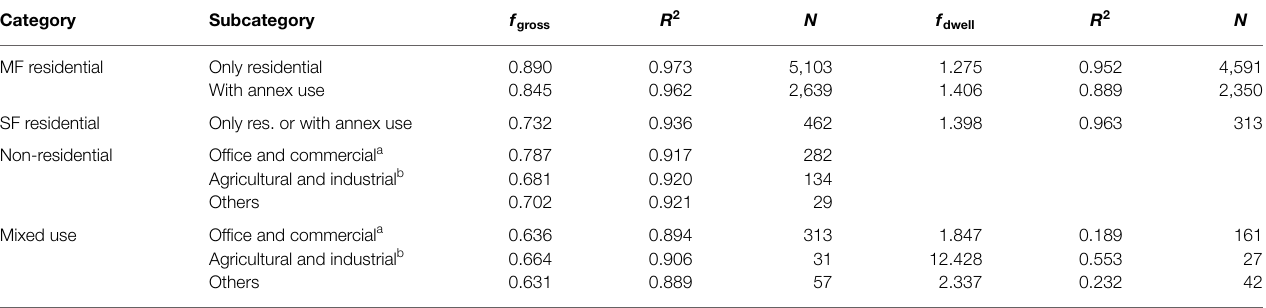
TABLE 1 | Regression coefficients between heated floor surface and gross surface ( f gross ) and between heated floor surface and dwelling surface ( f dwell ), as observed in the IDC database. Category Subcategory f gross R 2 N f dwell R 2